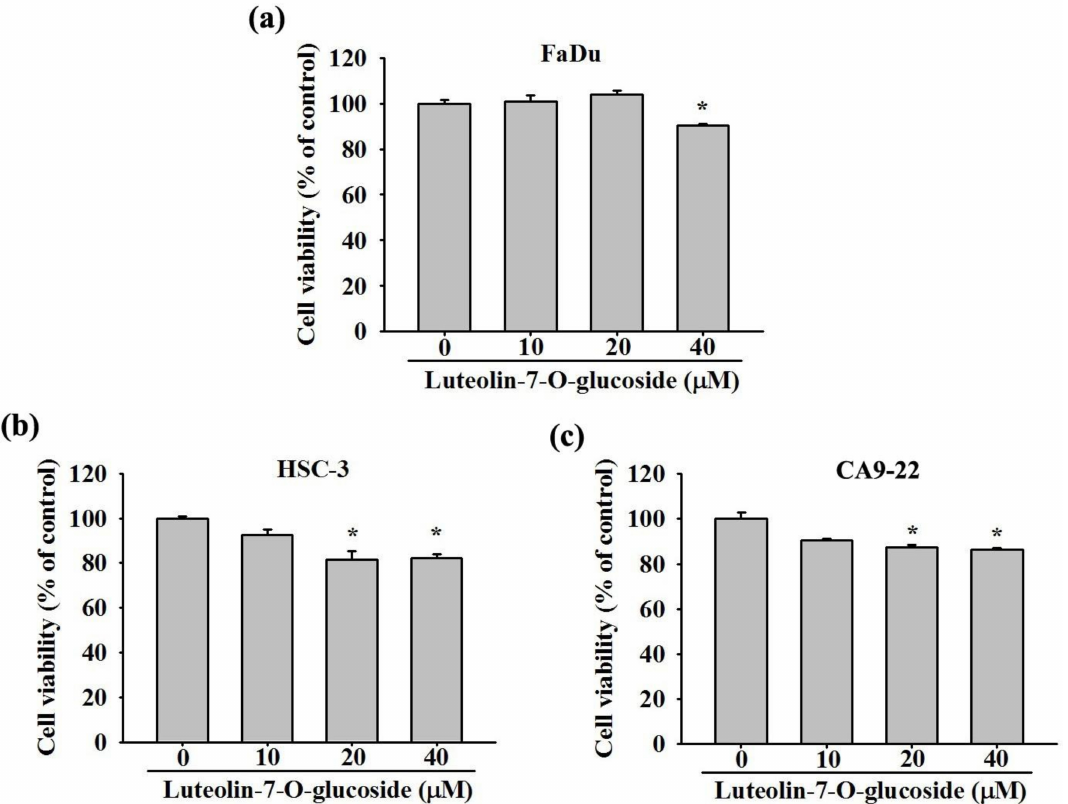
Figure 1. Cytotoxicity of Luteolin-7-O-glucosidein human oral cancer cells. ( a ) FaDu, ( b ) HSC-3, and ( c ) CA9-22 cell lines were treated with various concentrations (0, 10, 20, and 40 µ M) of luteolin-7-O-glucoside for 24 h, and the cell viability was determined by MTT assay. The values are represented as mean ± SD of at least three independent experiments. * p < 0.05, compared with the control